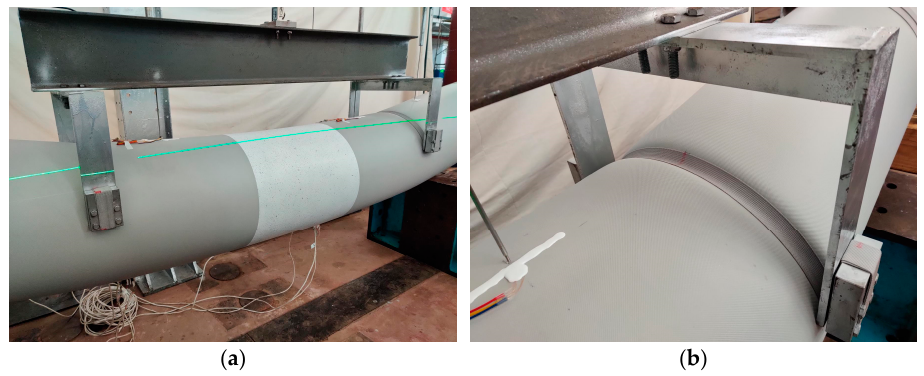
Figure 10. Deflected process of the inflated sample: ( a ) initial loading; ( b ) close to ultimate load.